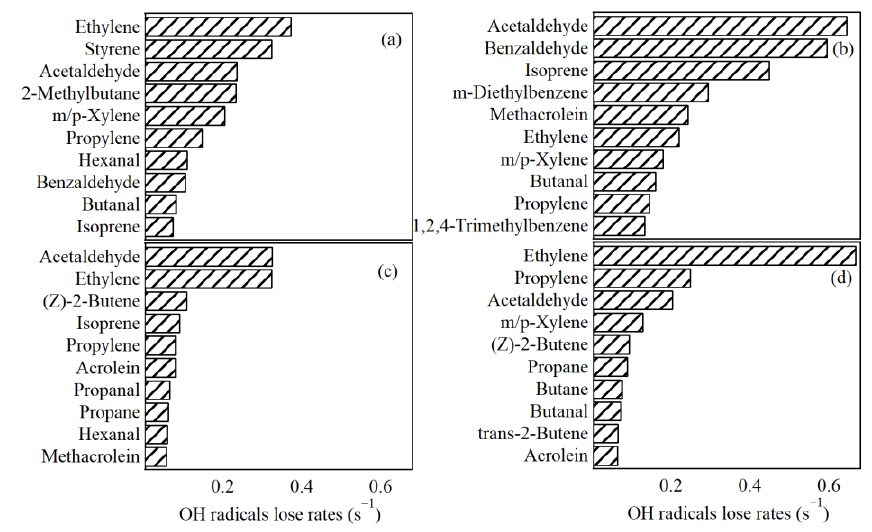
Figure 12. Top ten species of L OH in ( a ) spring, ( b ) summer, ( c ) fall, and ( d ) winter.